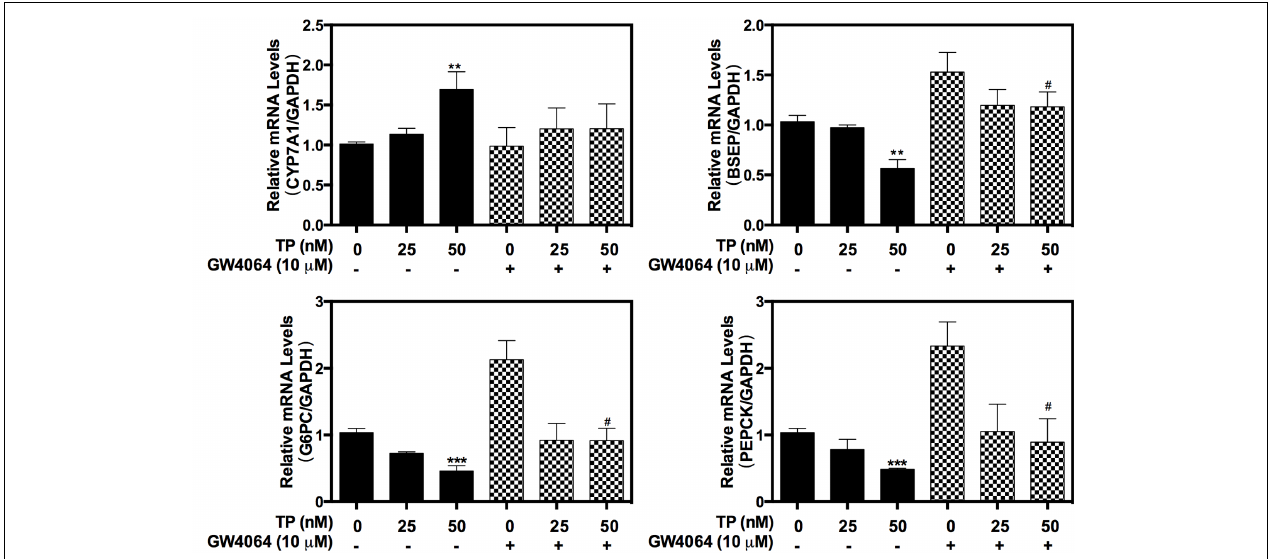
FIGURE 3 | Effect of GW4064 on TP-induced hepatotoxicity in primary rat hepatocytes. Primary rat hepatocytes were pretreated with the FXR agonist, GW4064 (10 µ M), for one hour and then treated with TP for 8 h. The mRNA levels of FXR-target genes were determined using real-time RT-PCR and normalized to GAPDH as an internal control. Statistical significance relative to vehicle control, ∗ p < 0.05, ∗∗ p < 0.01, ∗∗∗ p < 0.001; and statistical significance relative to the corresponding treated groups without GW4046, # p < 0.05, ## p < 0.01, ### p < 0.001.